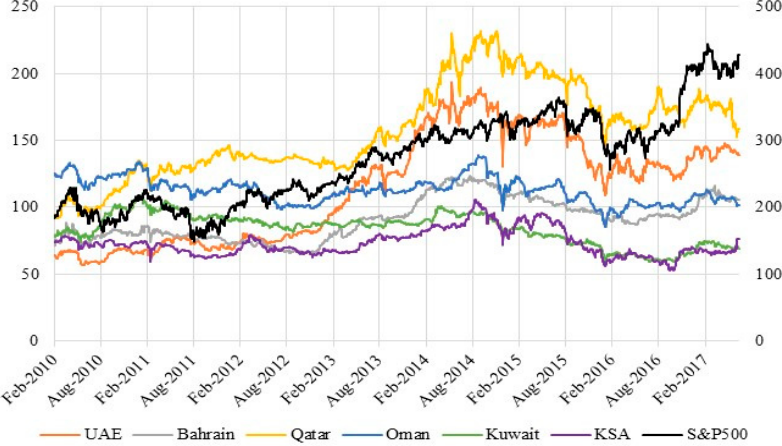
Figure 1. Time series plots for daily GCC and S&P 500 banking sector price indices for the period February 2010 to June 2017 (S&P 500 banking sector prices indicated on the right axis).